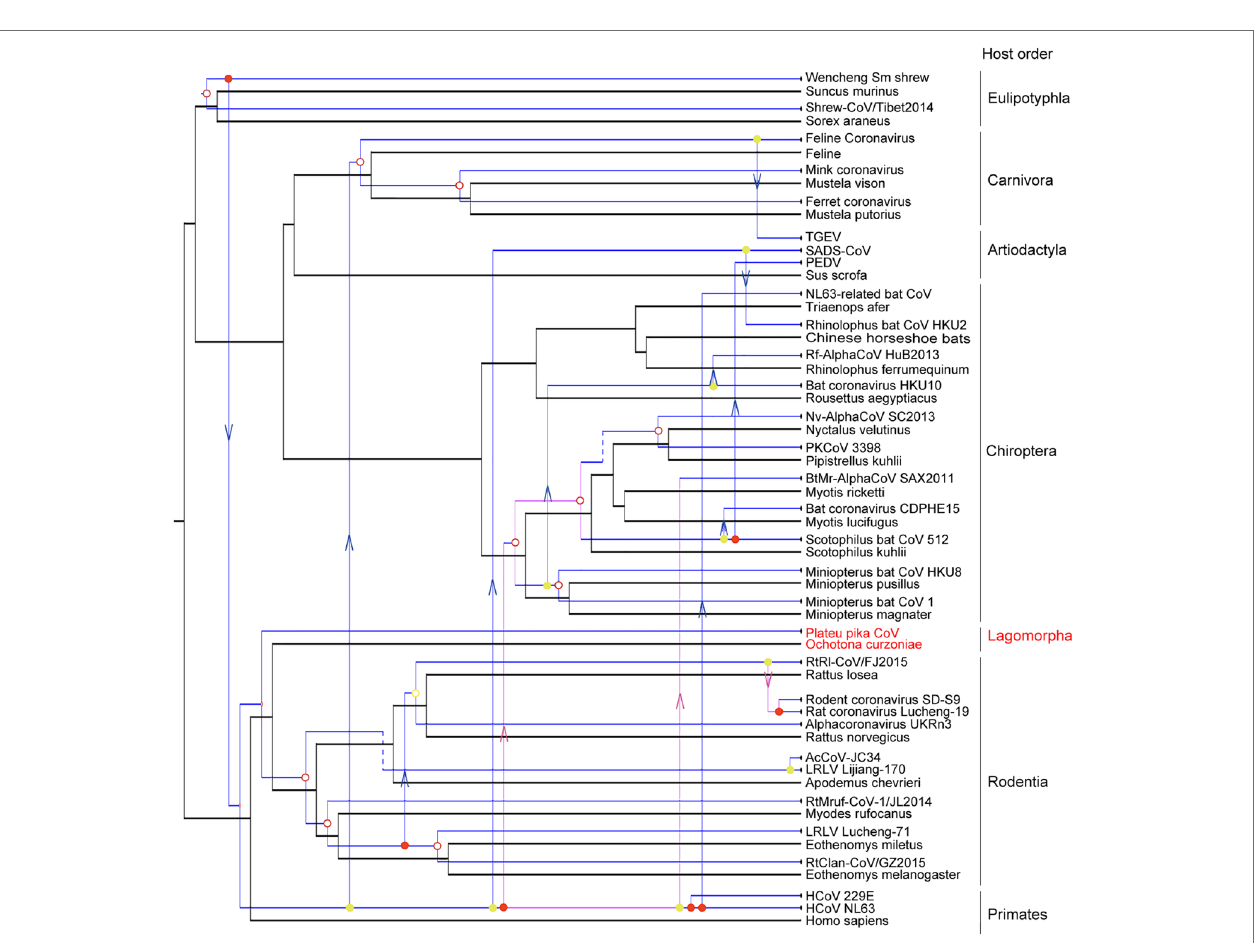
FIGURE 5 | Co-phylogenetic analyses of alphacoronaviruses and their hosts. The host tree is labeled in black with coronavirus tree in blue. Co-divergence events, duplication events, host-switching events, and loss events were labeled with filled circles, empty circles, arrows, and dotted lines, respectively. The virus from this study is labeled with a red